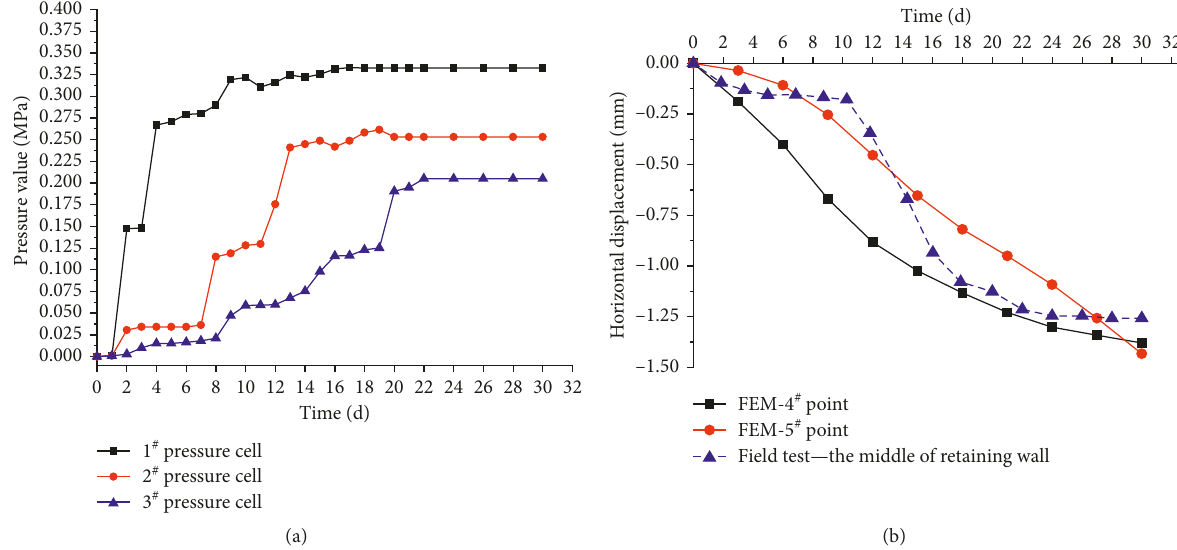
Figure 15: Pressure test of the retaining wall. (a) Relationship between retaining wall pressure and time. (b) Horizontal displacement in the middle of the retaining